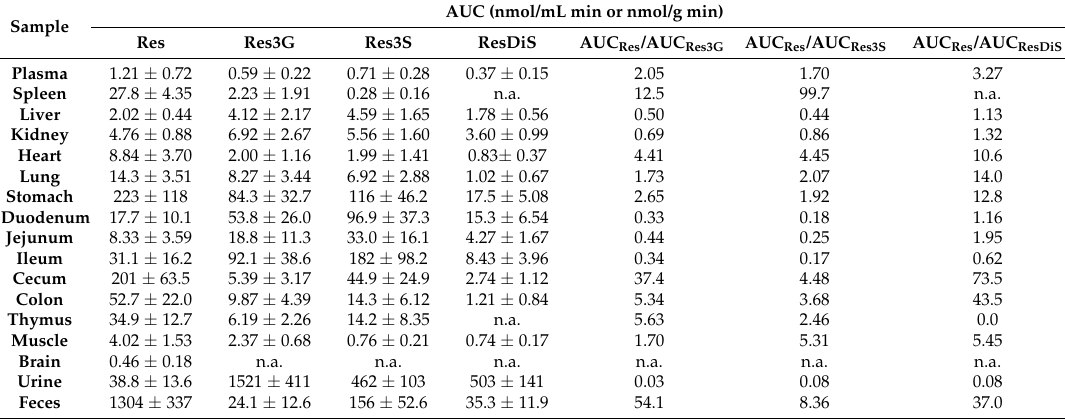
Data are expressed as mean ± SD; n = 3. n.a.: not